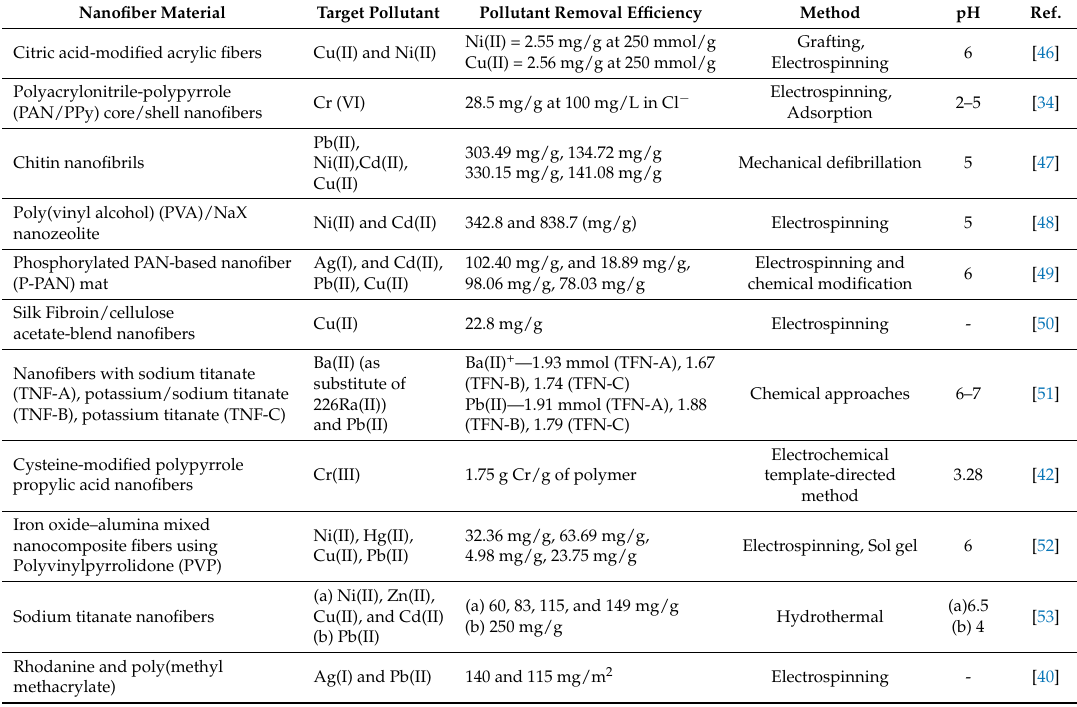
Table 1. Composite nanofiber membranes for heavy metal